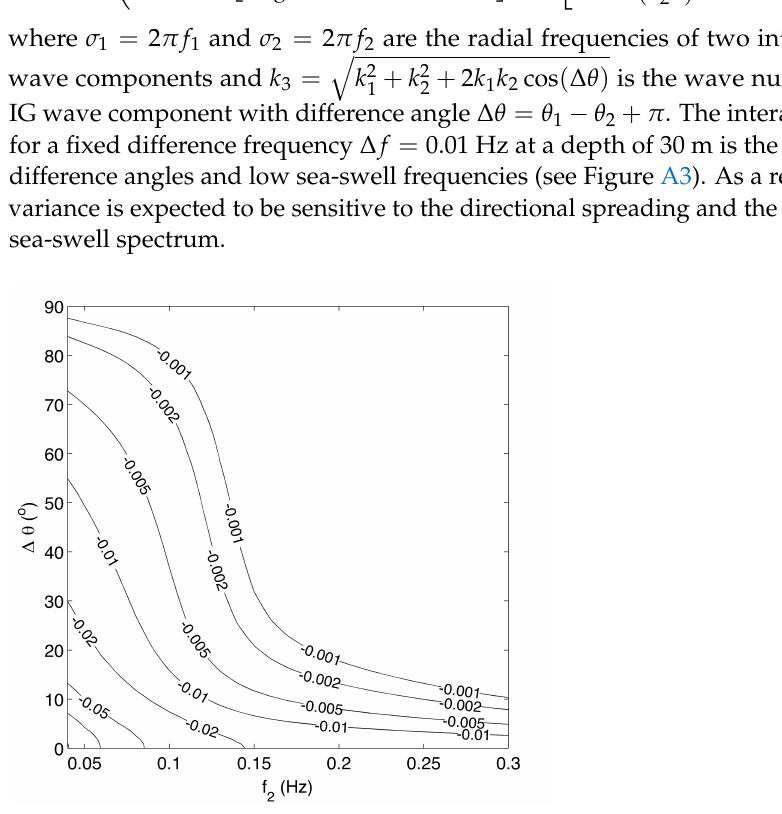
Figure A3. Interaction coefficient G for ∆ f = 0.01 Hz at 30 m water depth. The bound IG wave height is obtained by integrating over the appropriate IG fre- quency